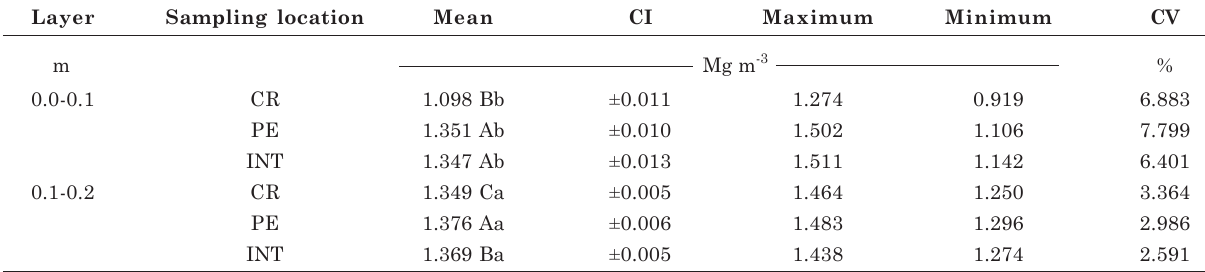
Mean, confidence interval (CI), maximum and minimum have the same unit as the corresponding soil property. Means followed by the same letter, uppercase for comparison in the same layer and lowercase for comparison of the same position between layers, do not differ significantly by the mean confidence interval (p>0.05).